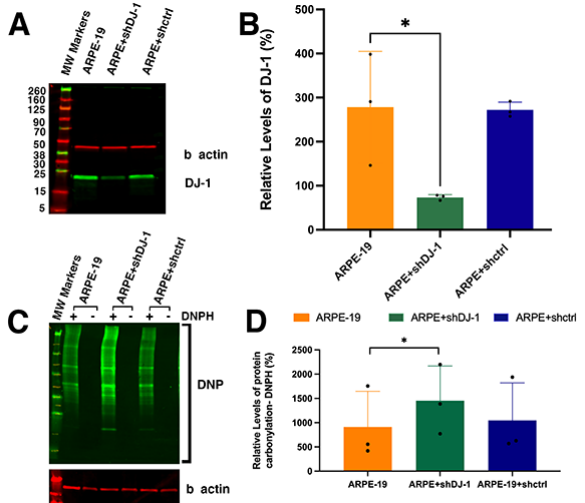
Figure 1. ROS is increased in RPE cells with DJ-1 downregulation. ( A ) Representative Western blot of RPE monolayers reacted with DJ-1 and β actin. ( B ) Total levels of DJ-1 protein in the RPE lysates. ( C ) Representative Western blot of RPE monolayers reacted with DNP (carbonyl groups) and β actin. ( D ) Total levels of DNP in the RPE lysates. Data are expressed as mean ± SD. * p = 0.01 to 0.05; one-way ANOVA; n = 3. Dots in ( B , D ) = individual experiments; asterisks above for